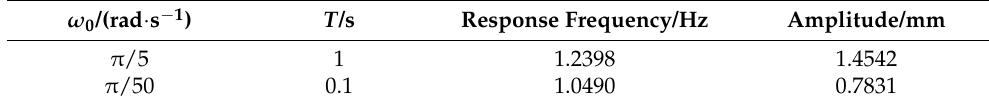
Table 9. Dynamic responses of point A of M1 with the same acceleration.